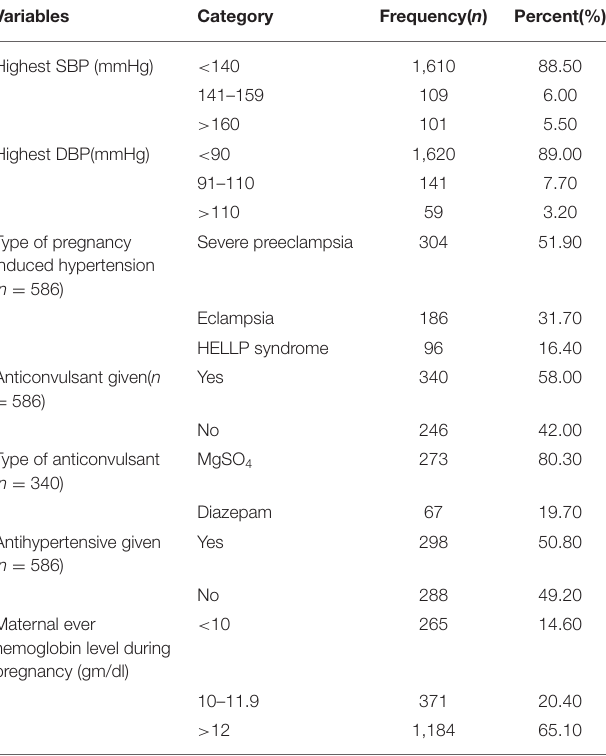
TABLE 1 | Obstetric characteristics of perinatal mortality among mothers who attended ANC in Gamo Zone, Southern Ethiopia, 2019. Variable